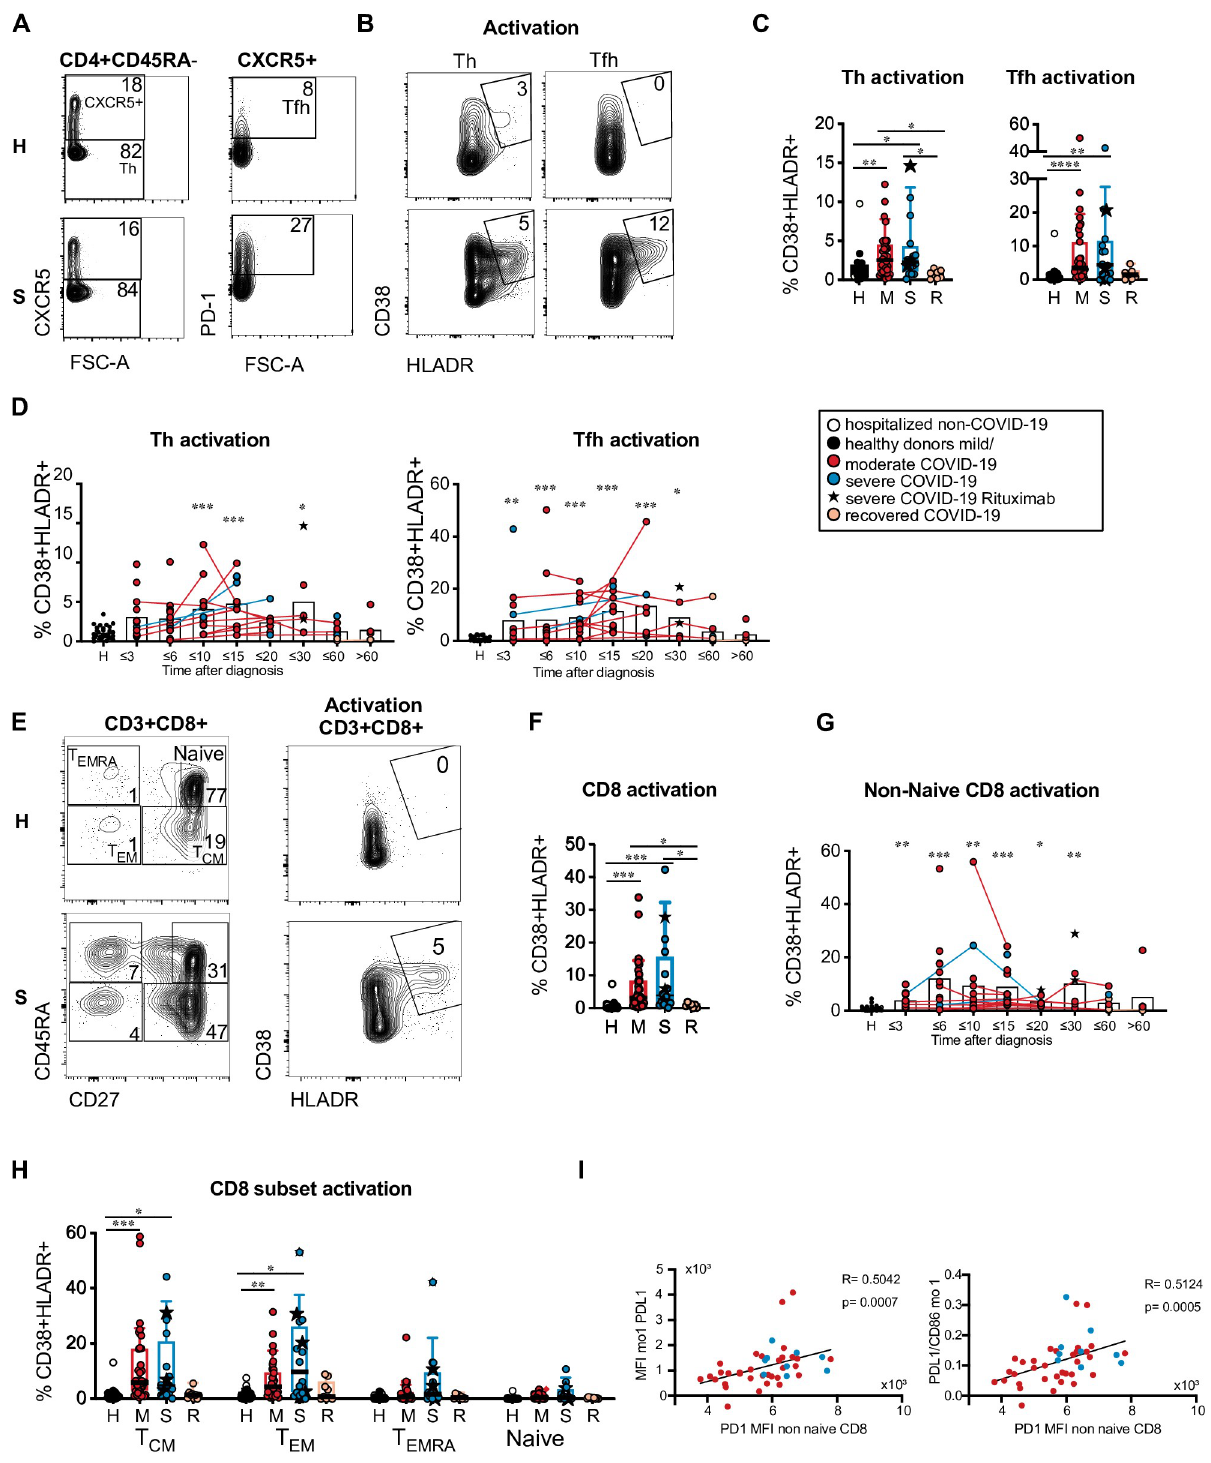
Fig 7. Heterogeneous T cell activation in COVID-19 patients. (A and B) Representative results of one healthy donor and one COVID-19 patient with severe disease are shown. Numbers indicate percentages. (A) CXCR5 and PD-1 expression in CD3 + CD4 + CD45RA − CD25 lo/int T cells and gating of Tfh-like cells. (B) CD38 and HLADR expression in CXCR5 – Th and CXCR5 + PD-1 + Tfh-like cells. (C) Percentage of activated cells within Th and Tfh-like cells in healthy/non-COVID controls (H, n = 24) and acute COVID-19 patients with mild/moderate (M, n = 35) or severe disease (S, n = 16)